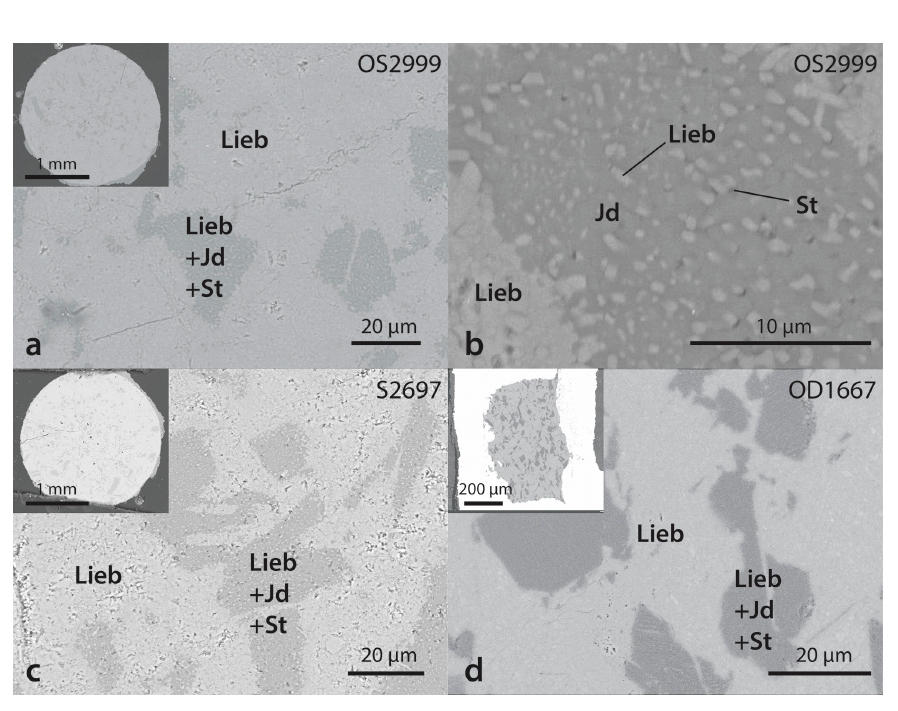
Figure 1. Electron image of ( a ) ( b ) the microcline sample before (OS2999) and ( c ) after (S2697) in situ measurements. ( d ) OD1667 show the result of an equilibrium experiment carried out for 12 h at ~21 GPa and 1700 K, corresponding to the highest pressure (P) and temperature (T) data of the in situ measurements (see Table 1). Abbreviations: Lieb, Na-rich liebermannite; Jd, jadeite; St, stishovite. Table 2. Composition of starting material and run Table 1. Experimental conditions and run products.